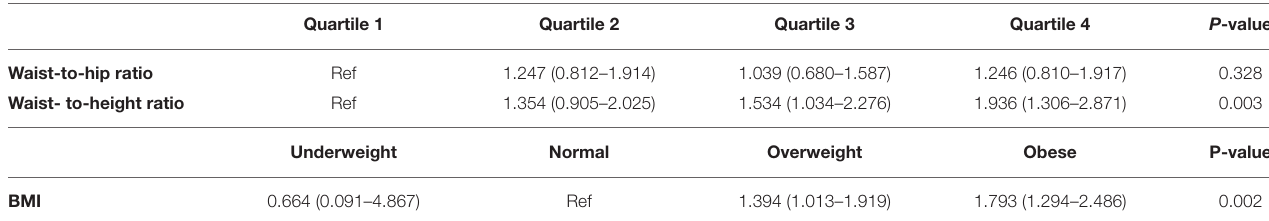
TABLE 3 | Hazard ratio of incident hypertension based on waist-to-height ratio, waist-to-hip ratio and BMI during the follow-up period; Data are presented as HR (95% CI); Results are adjusted for age, gender, history of CAD, SBP, DBP, FPG and family history of